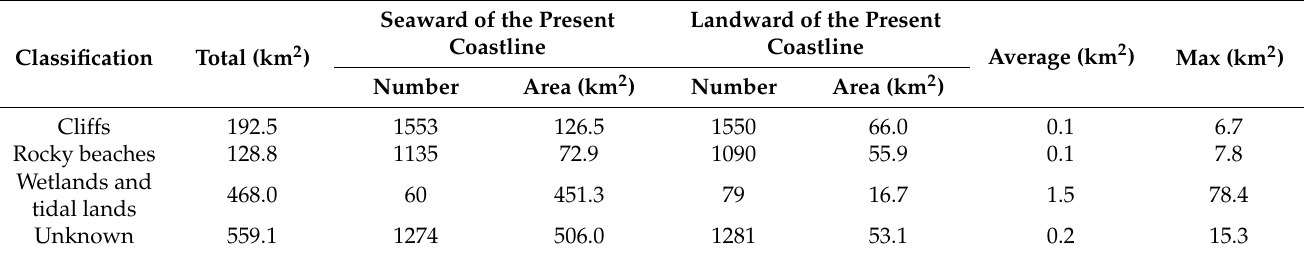
Table 1. Number of gaps and their areas in the non-surveyed (estimated) coastlines in